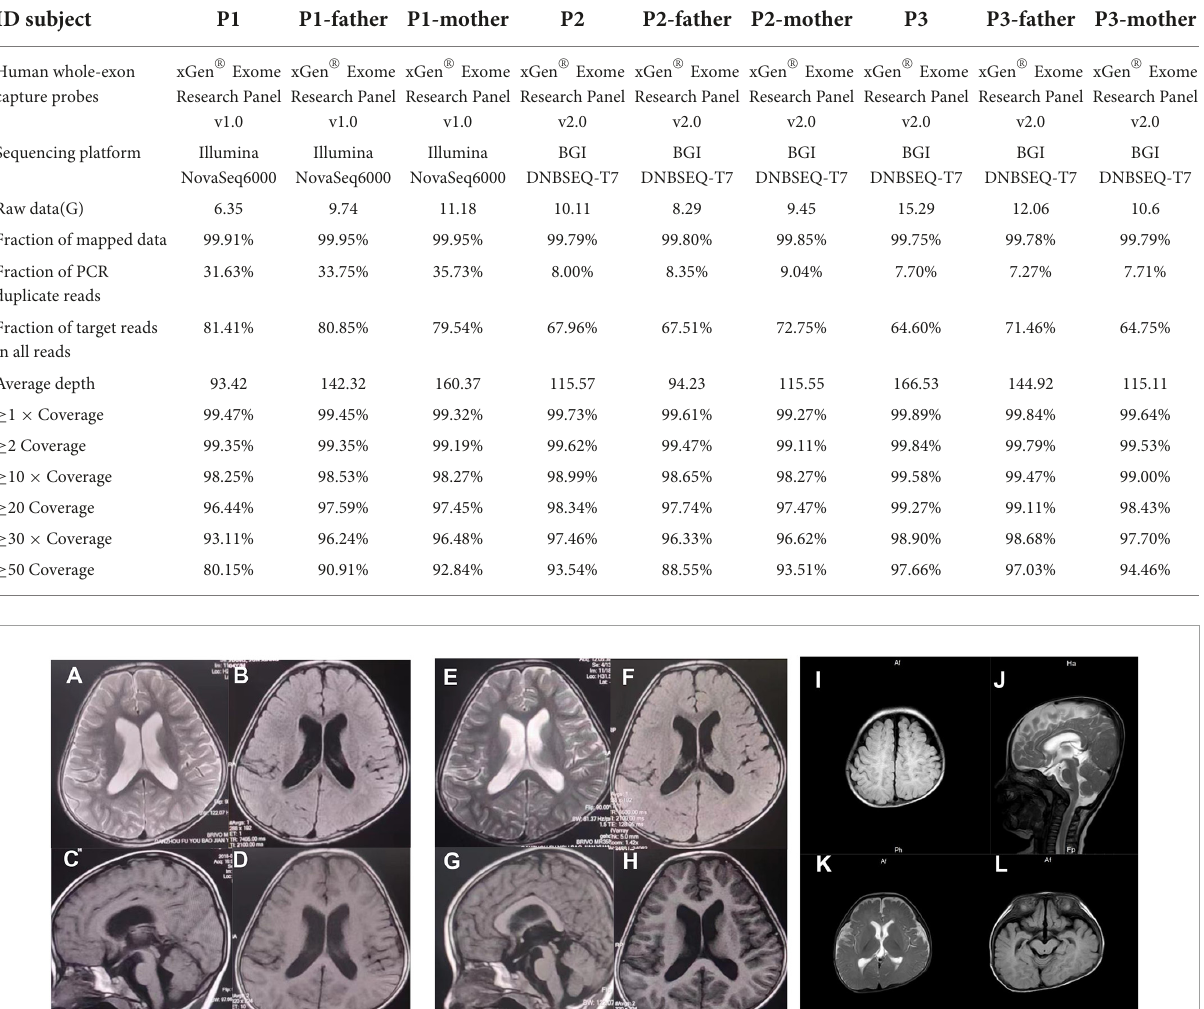
TABLE 1 Quality control data of whole exome sequencing.